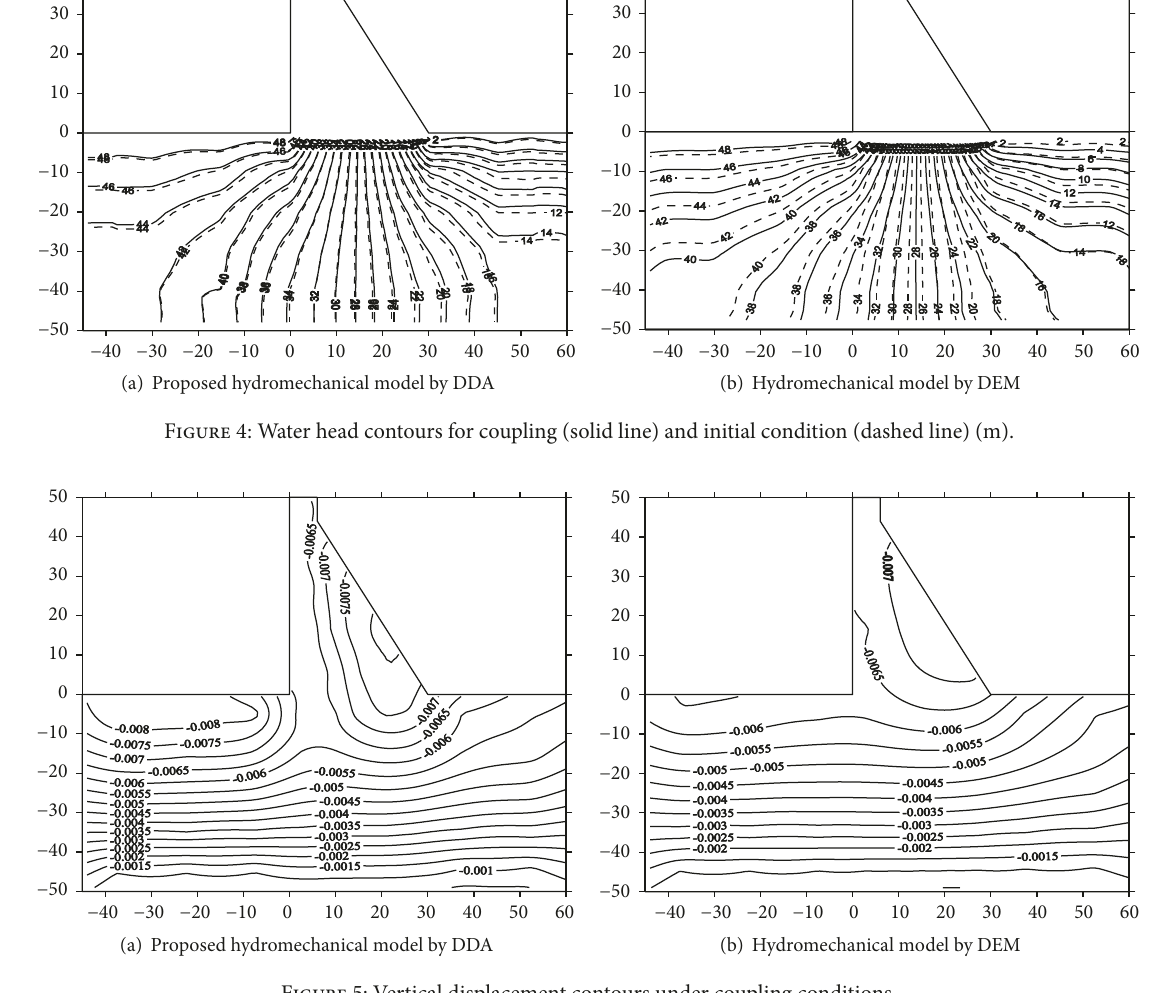
Figure 5: Vertical displacement contours under coupling conditions.